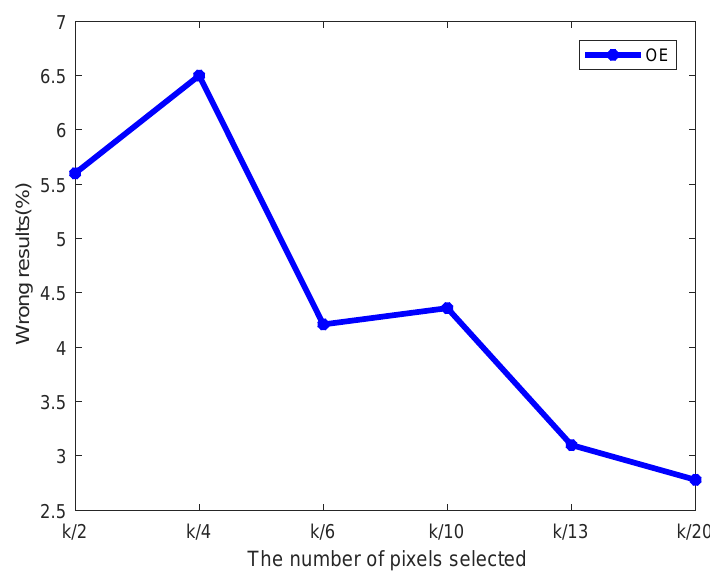
Figure 16. The overall error ( OE ) on the Yellow River dataset according to different numbers of pixels selected.